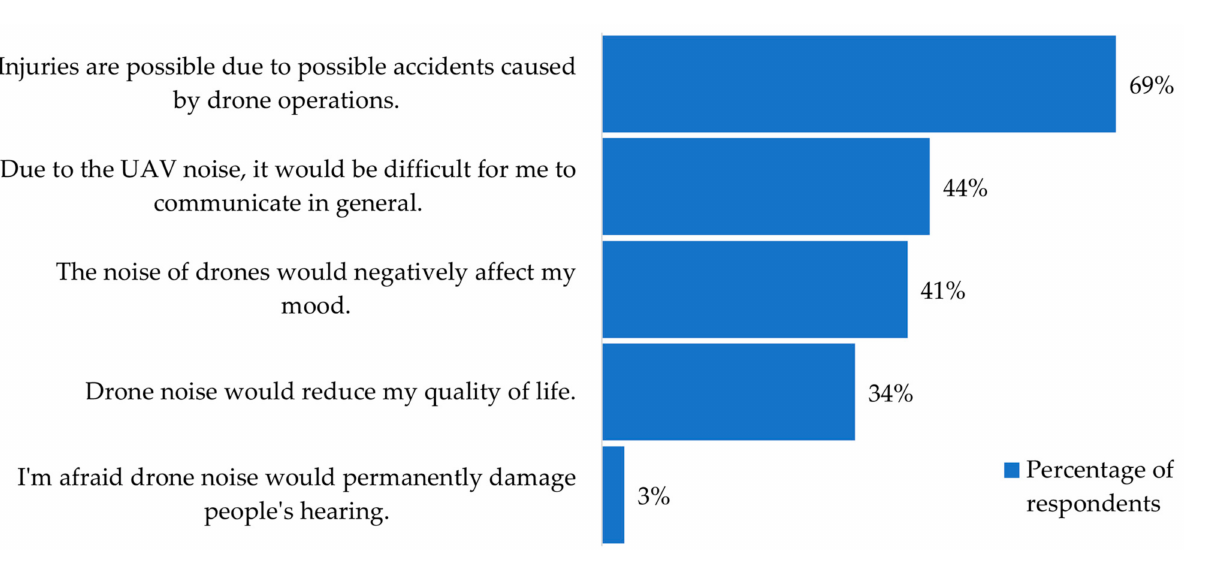
Figure 8. Concerns regarding introduction of